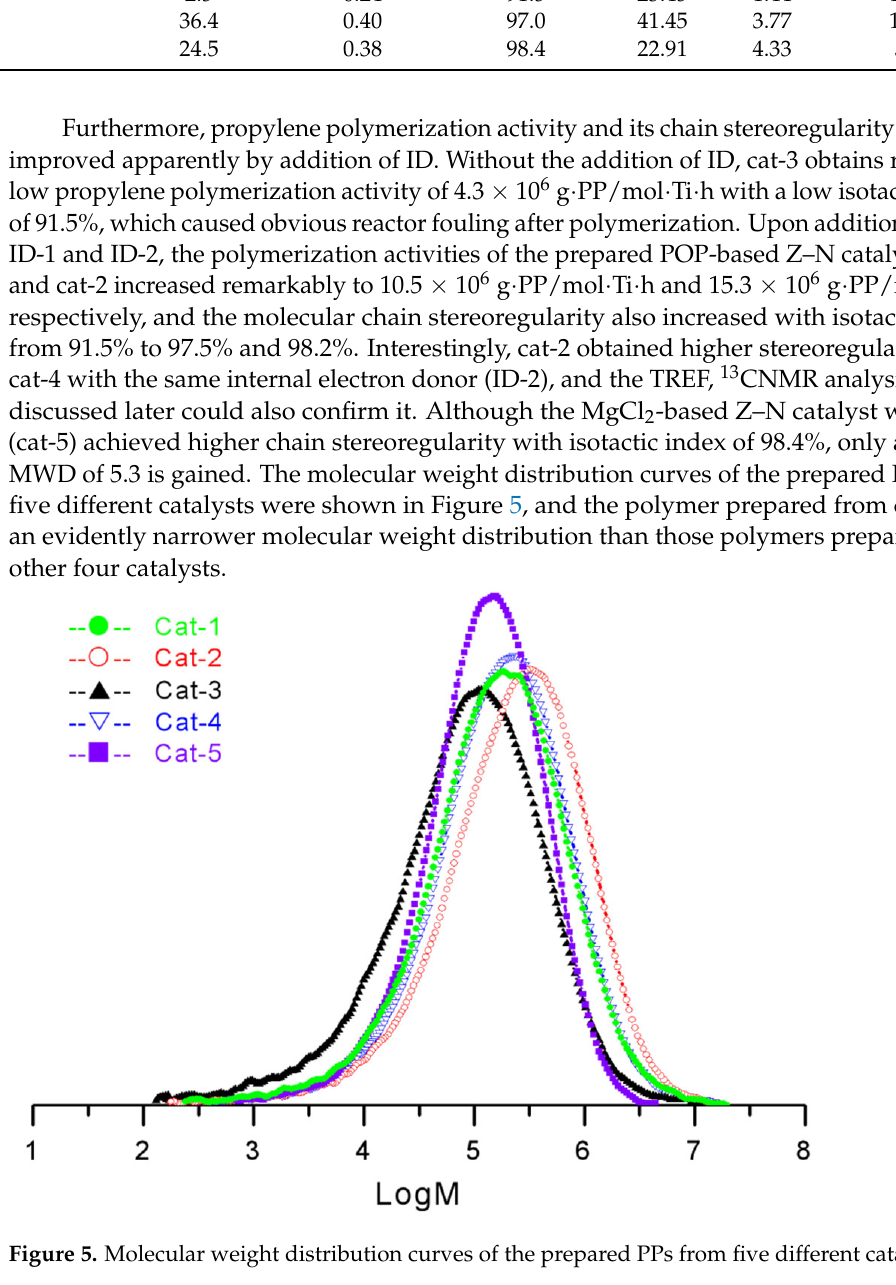
Figure 5. Molecular weight distribution curves of the prepared PPs from five different catalysts. DSC, TREF and 13 CNMR analyses were characterized to further evaluate the mi- crostructure of PP molecular chains. As discussed above, a high isotacticity index ( ≥ 97%) could be obtained from the Z–N PP catalysts with extra IDs from Soxhlet extraction method using n-heptane, and the stereoregularity of PP molecular chains is highly related to their melting and crystallization behaviors. From Figure 6 and Table 4, the PP melting peaks